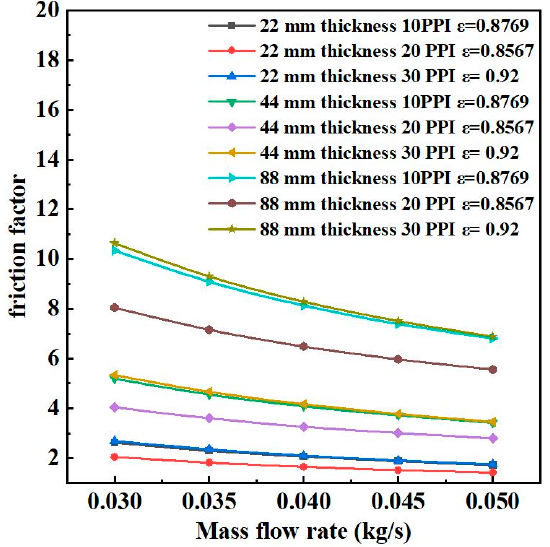
Figure 13. Variation of friction factor for different mass flow rates varying PPI and thickness of metal foam . metal